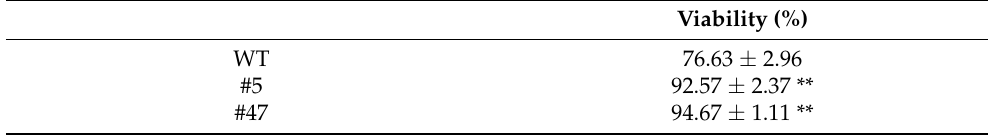
Table 2. Viability of AK2 mutants.